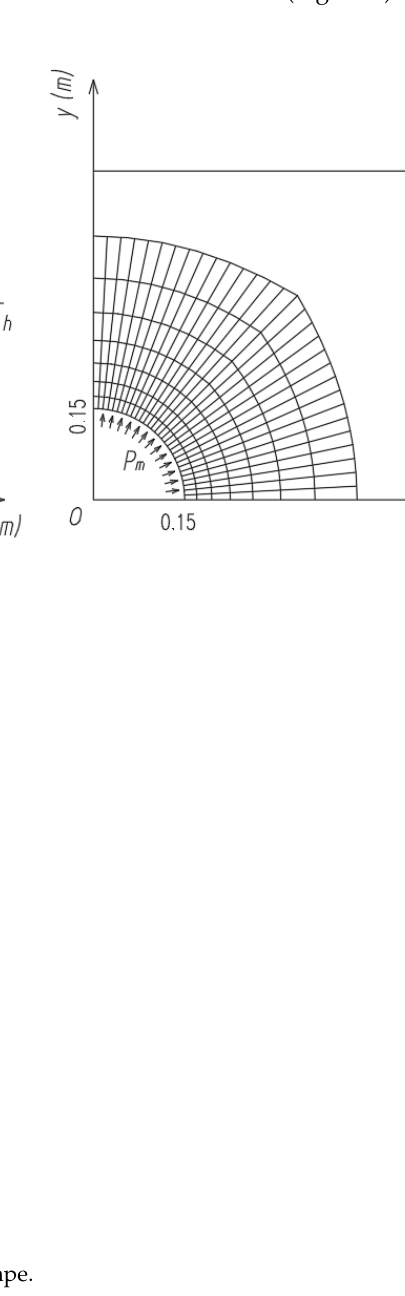
Figure 2. ( A ) Constant stiffness method, ( B ) Tangent stiffness method.